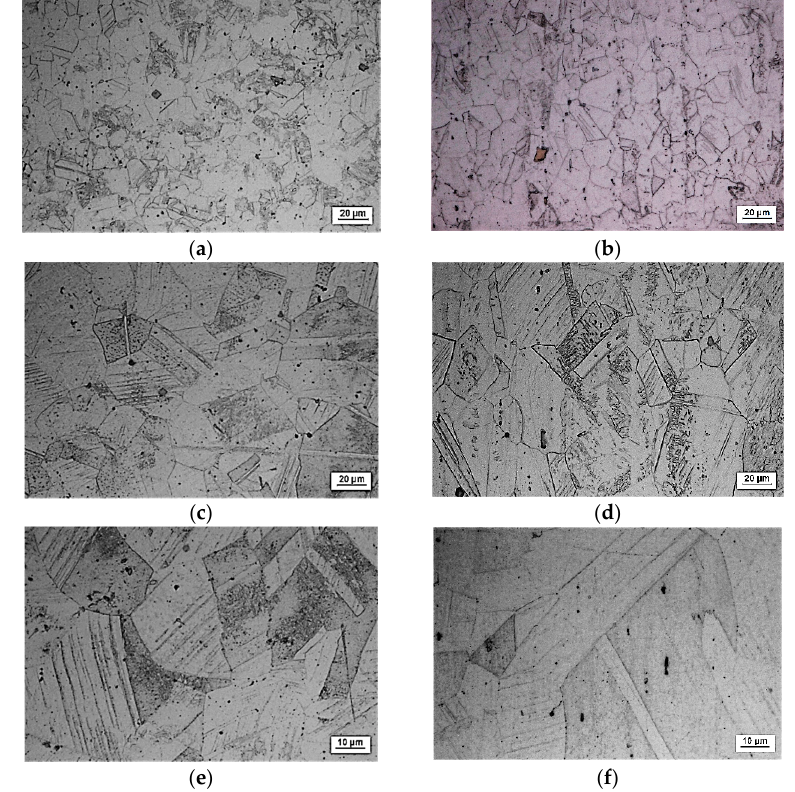
Figure 13. X6CrNiTi18-10 steel: optical micrographs, aqua regia. ( a ) As-received material (austenitic stainless steel, annealed bar), the cross-section of the specimen, 500×; ( b ) As received material, the longitudinal-section of the specimen, 500×; ( c ) After performing the creep process at 500 °C/153 MPa/1200 min, the cross-section of the specimen, 500×; ( d ) After performing the creep process at 500 °C/153 MPa/1200 min, the longitudinal-section of the specimen, 500×; ( e ) After performing the creep process at 700 °C/63 MPa/1200 min, the cross-section of the specimen, 1000×; ( f ) After the creep process performed at 700 °C/63 MPa/1200 min, the longitudinal-section of the specimen, 1000×.